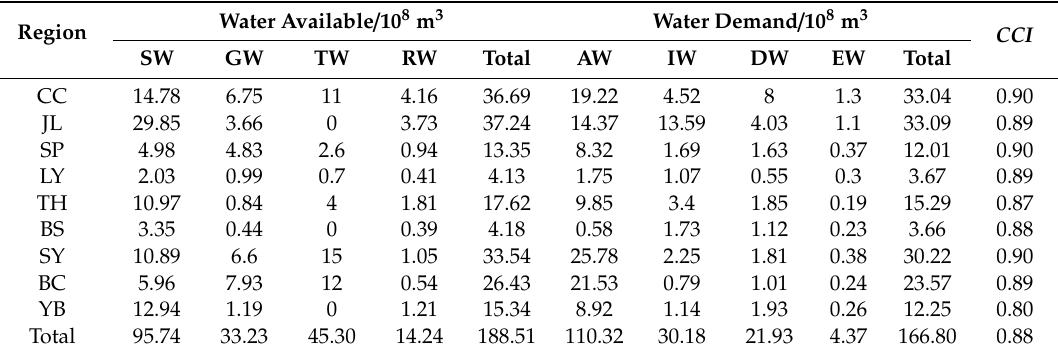
Table 8. Water allocation results of Jilin province in